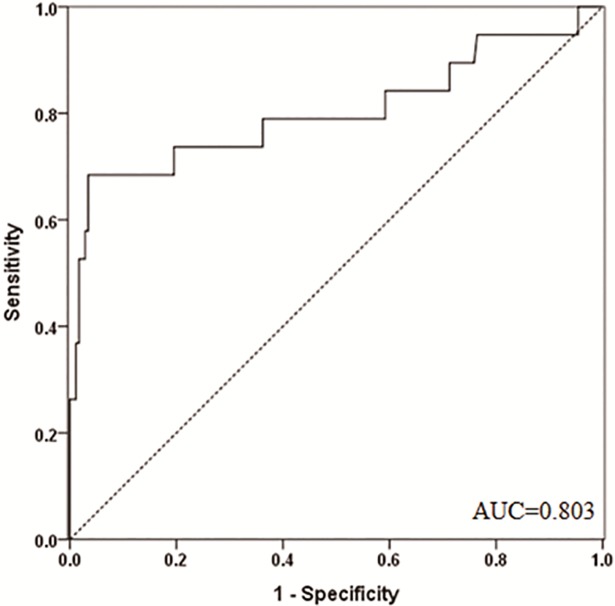
ROC curve for the ability of preoperative serum MMP-2 to predict SPRD.